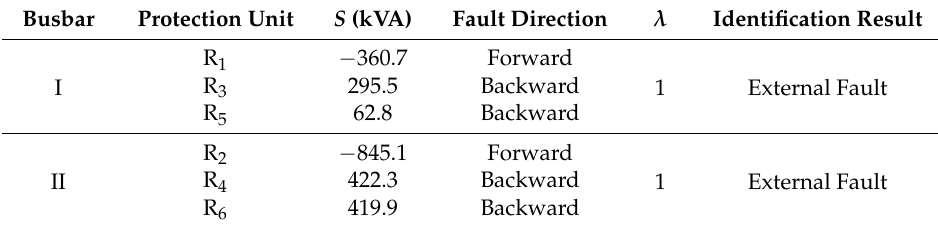
Table 2. Simulation results for a typical external fault.